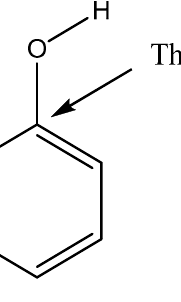
Figure 1. The phenolic carbon on a compound is the carbon directly bonded to the oxygen of the phenol group.